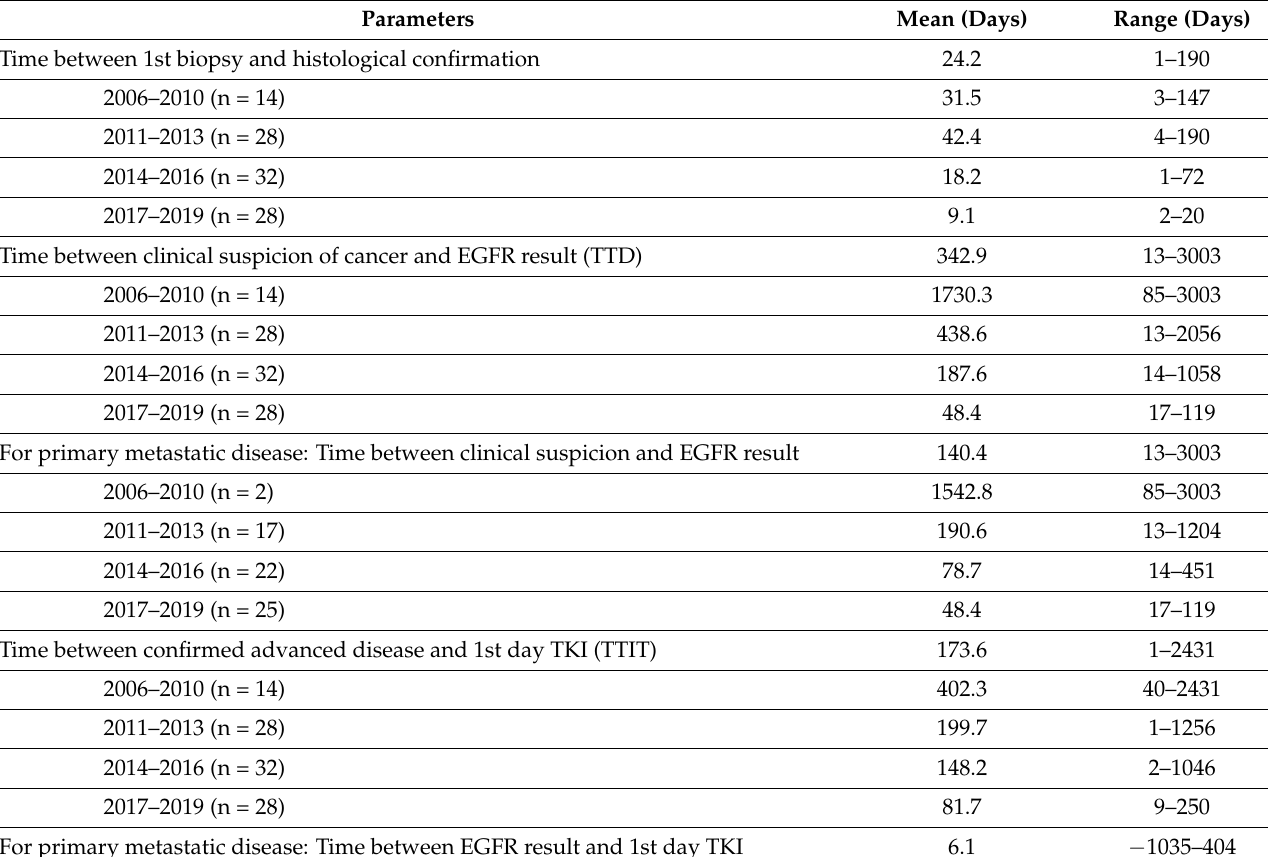
Table 2. Time to histological confirmation, EGFR mutation result and 1st day of anti-EGFR TK. * Some patients had started TKIs before molecular